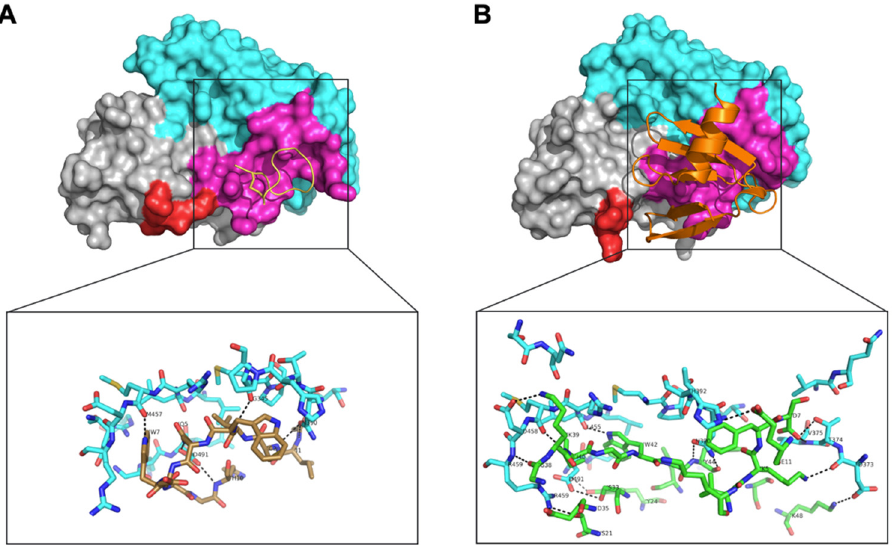
Figure 8. Comparison of the complex structures of compstatin with C3c, and APL-1030 with C3b. The complex structures of ( A ) compstatin, and ( B ) APL-1030, with C3c (PDB 2QKI) and C3b (PDB 7TV9), respectively, with a focus on their MG4 (grey, aa329–aa426) and MG5 (cyan, aa427–aa534) domains. Residues of C3c in interaction with the compstatin are labelled in magenta. A loop (aa370–aa374) subjected to a structural rearrangement between the two complex structures is labelled in red. A comparison of the protein/peptide hydrogen bonds of the binding interface of ( A ) C3c/compstatin with ( B ) is shown in detail. Table 2. Comparison of Protein/Peptide Hydrogen Bonds of C3b/APL-1030 with C3c/Compstatin.